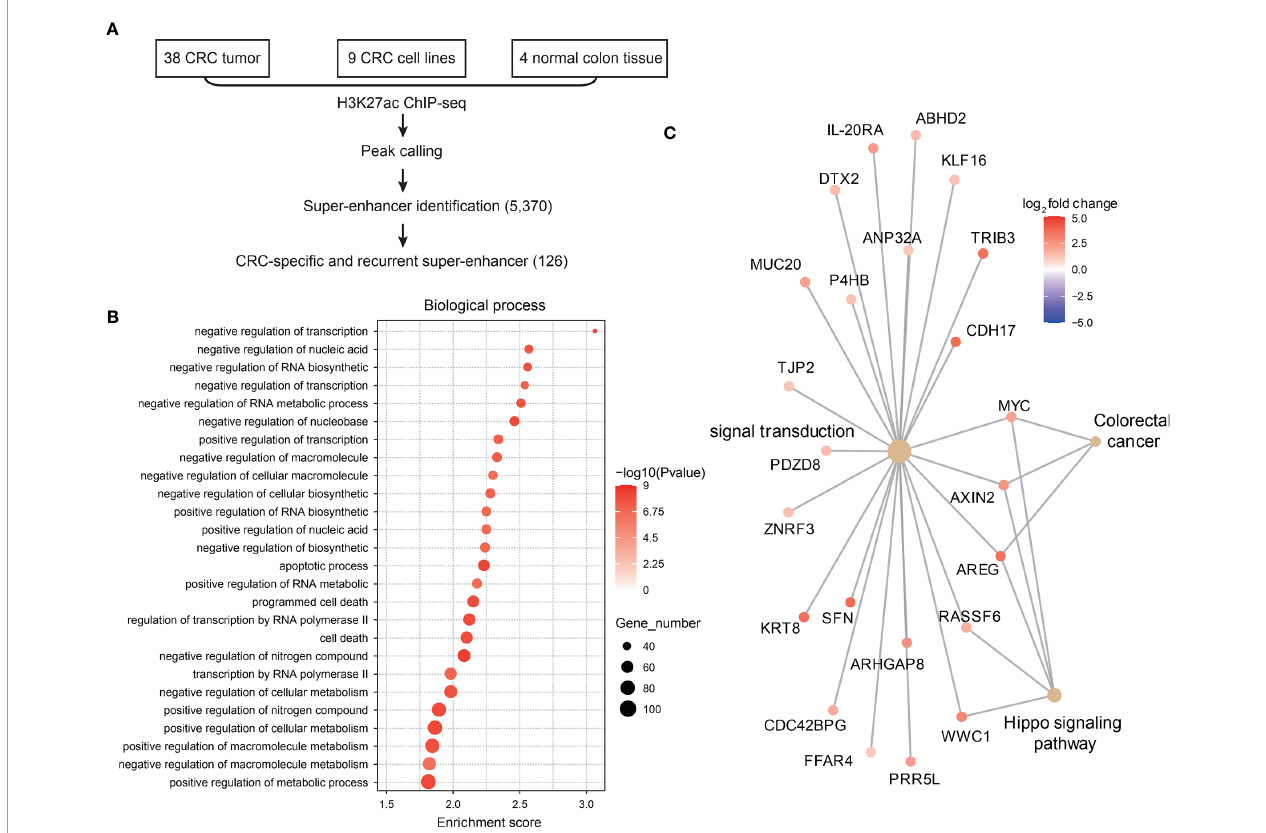
FIGURE 1 | Landscape of super-enhancers in colorectal cancer. (A) Schematic illustration of super-enhancer-related oncogene identi fi cation in CRC. (B) Gene ontology analysis of genes related to CRC-speci fi c super-enhancers. (C) Expression of CRC-speci fi c oncogenic super-enhancer-related genes in CRC and normal adjacent